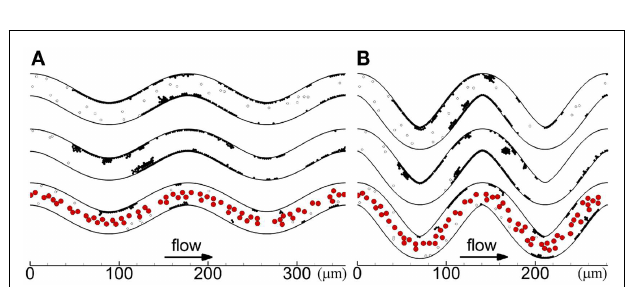
FIGURE 3 |Thrombus formation at t f with different seeding scenarios, including whole-lumen-seeded platelets (top), near-wall-seeded platelets (middle), and RBCs with platelets (bottom), for low tortuosity index (A) and high tortuosity index (B), for Cases 1–6 . Cells include activated platelets (black), unactivated platelets (white), and RBCs (red). Platelets are normal size.